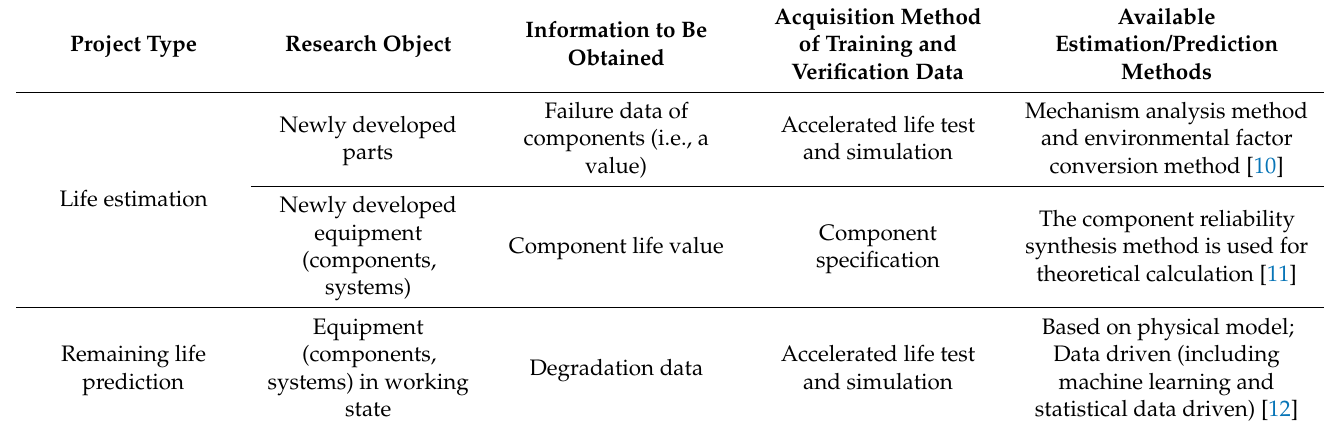
Table 2. Development of remaining life prediction